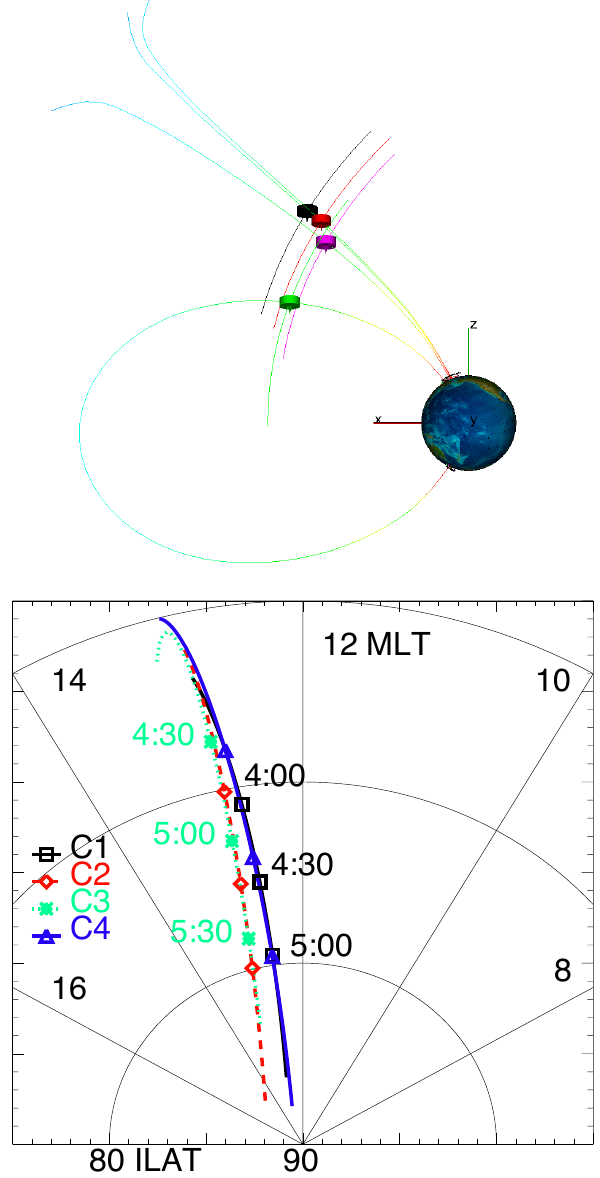
Fig. 2. Top: Cluster orbit in X − Y GSM plane at 04:30UT on 20 Au- gust 2002. Bottom: projection of orbit track in ILAT-MLT diagram. The colours of the spacecraft are the usual Cluster colours (C1, black; C2, red; C3, green; C4, blue). The times on the right of the orbit tracks are associated with the positions of the three spacecraft C1, C2 and C4 and the times on the left to C3. The time delays of the cusp entry, around 71 ◦ ILAT, are d t 12 = 5min, d t 14 = 15min and d t 13 =